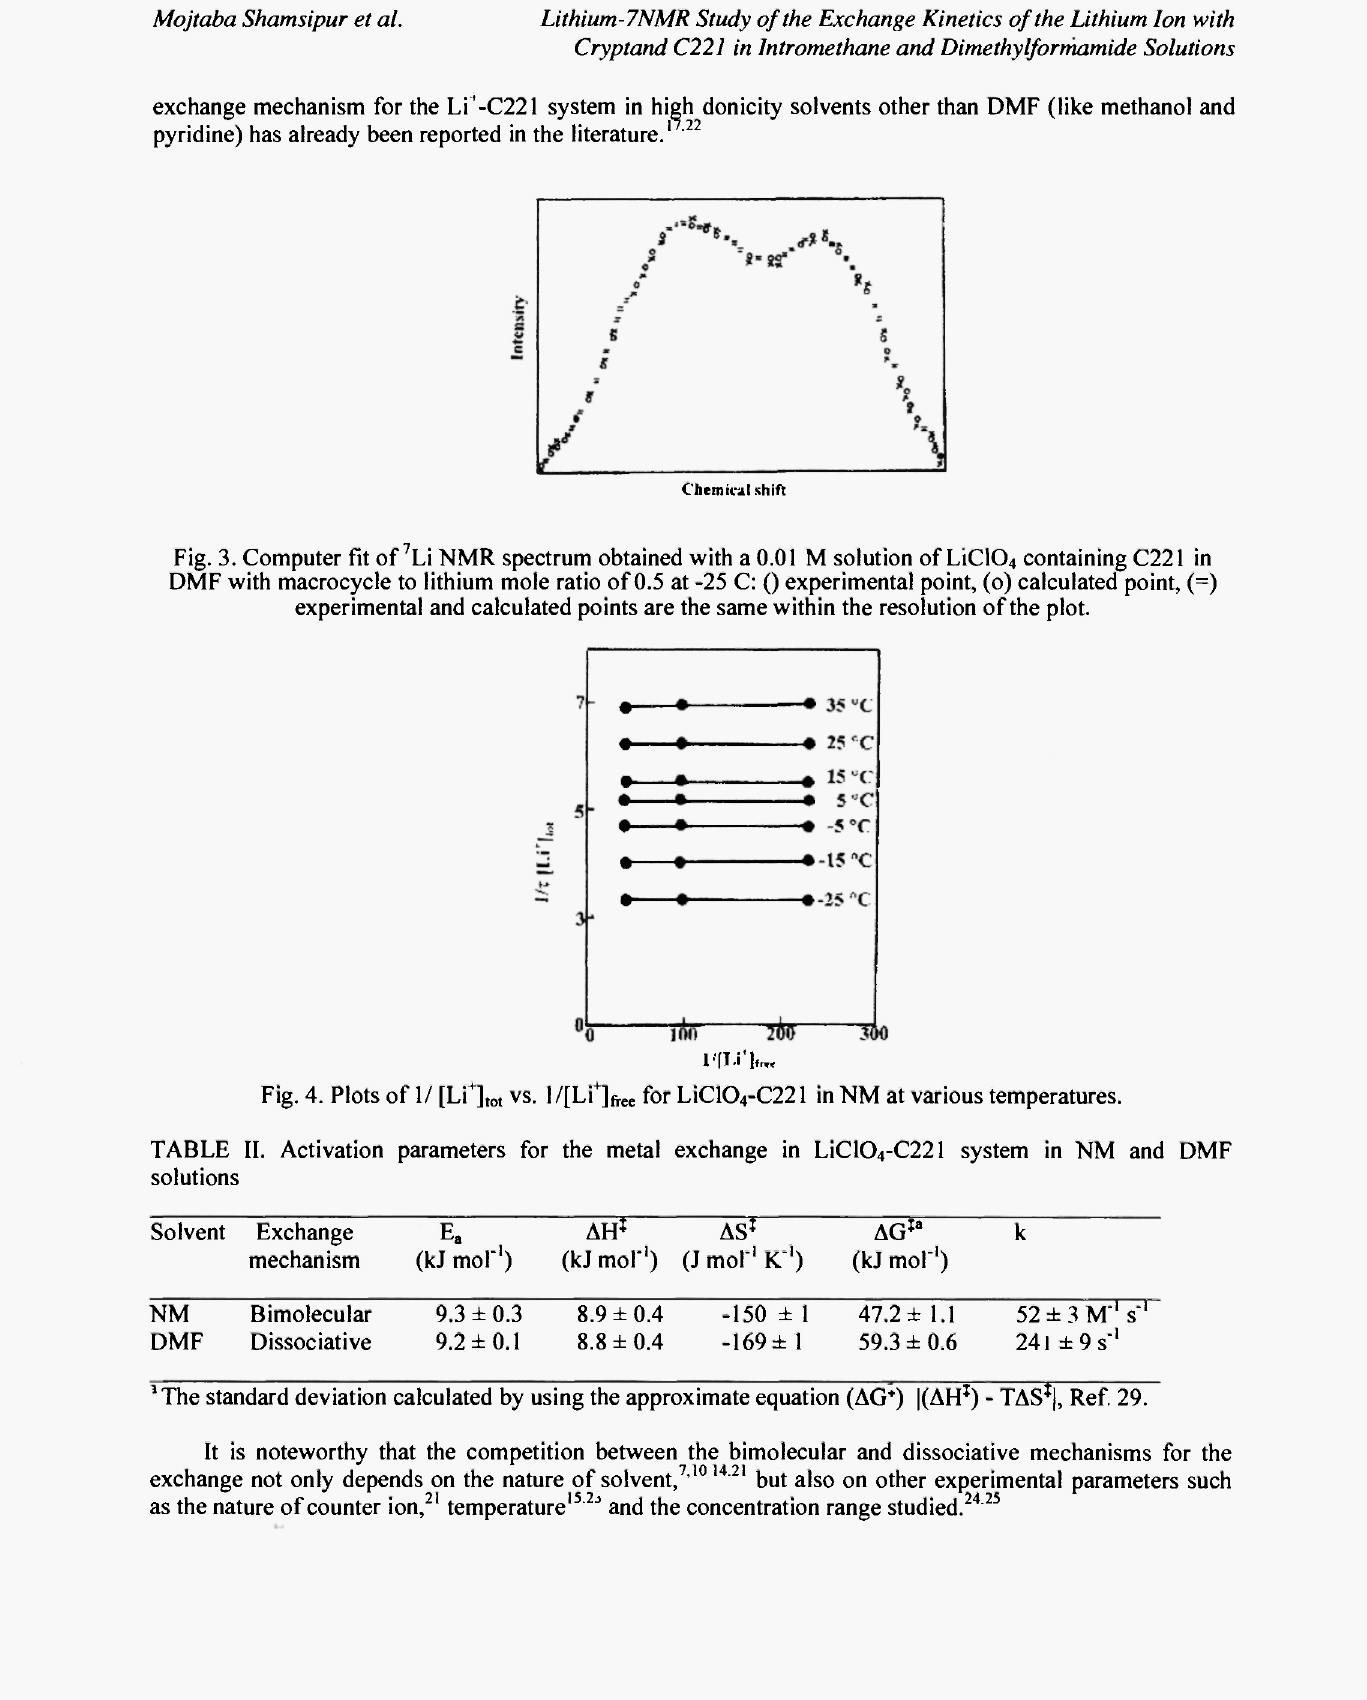
Fig. 4. Plots of 1/ [Li + ] to , vs. l/[Li + ] free for LiC10 4 -C221 in NM at various temperatures. TABLE II. Activation parameters for the metal exchange in LiC10 4 -C221 system in NM and DMF